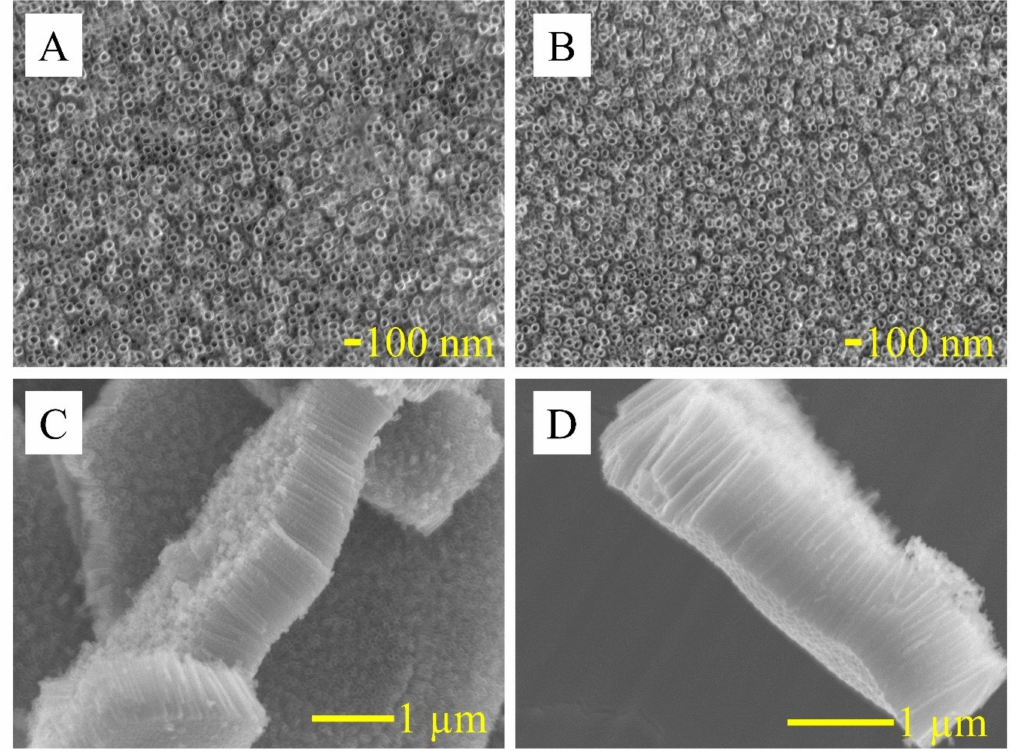
Figure 1. SEM images of top view ( A,B ), and cross view ( C,D ) of TNT ( A,C ), and TNT annealed in argon ( B,D ) at 550 ◦ C during 2